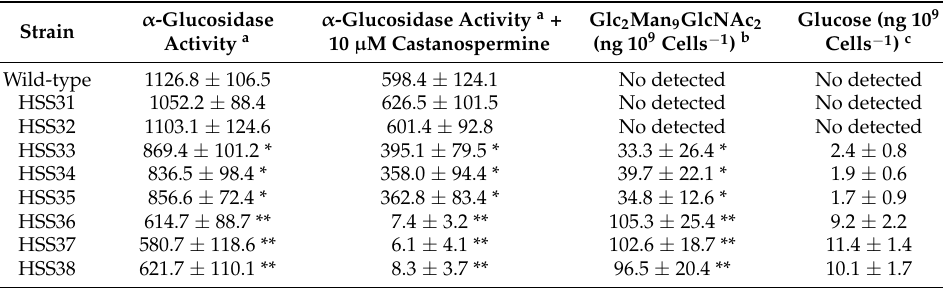
Table 1. α -Glucosidase activity and analysis of the N -linked glycan core in wild-type, control, and ROT2 -silenced mutant